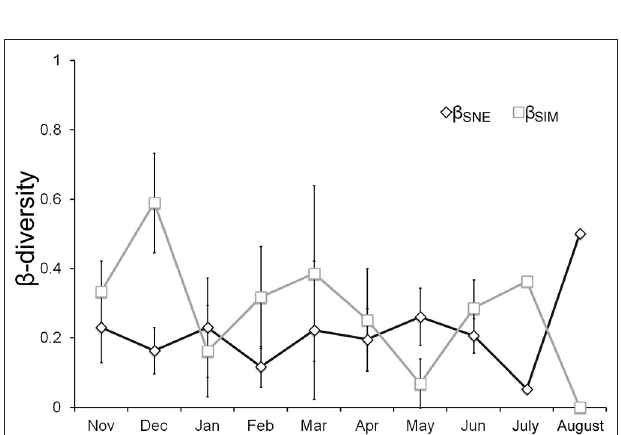
FIGURE 5 | Average values of the components of the macroinvertebrate β -diversity, the species replacement ( β SIM ) and the contribution of the nestedness ( β SNE ) to the β -diversity after β -diversity partitioning. Bars indicate the standard deviation (SD); July and August do not show SD because only a pair-wise comparison between the three ponds that maintained water by that time was performed.